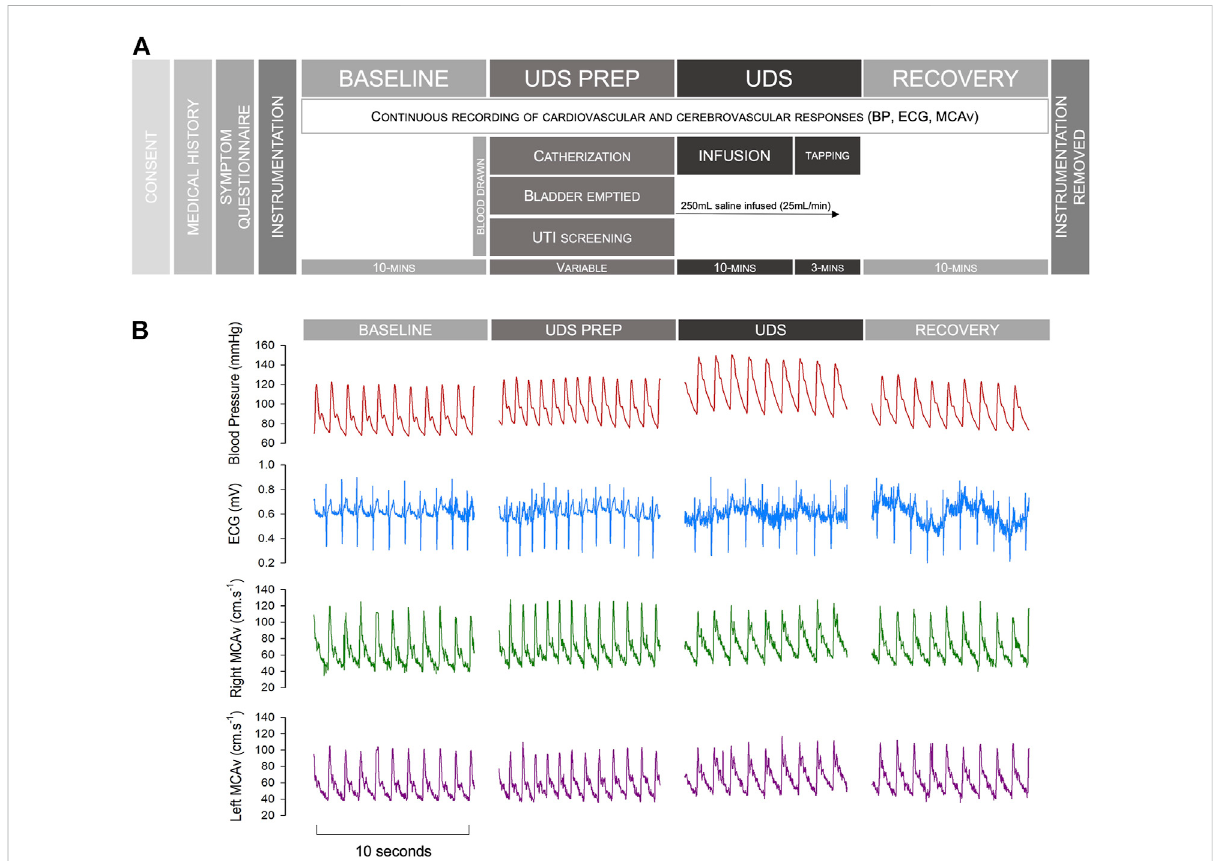
FIGURE 1 Study protocol and example traces. (A) Study protocol. (B) Representative example traces from an individual with an autonomically-complete SCI during different phases of testing. Note that occasional noise on the ECG tracing re fl ects muscle spasm in this individual with severe spasticity, particularly during AD. Abbreviations: BP, blood pressure; ECG, electrocardiogram; MCAv, middle cerebral artery blood fl ow velocity; UDS, urodynamics study; UTI, urinary tract